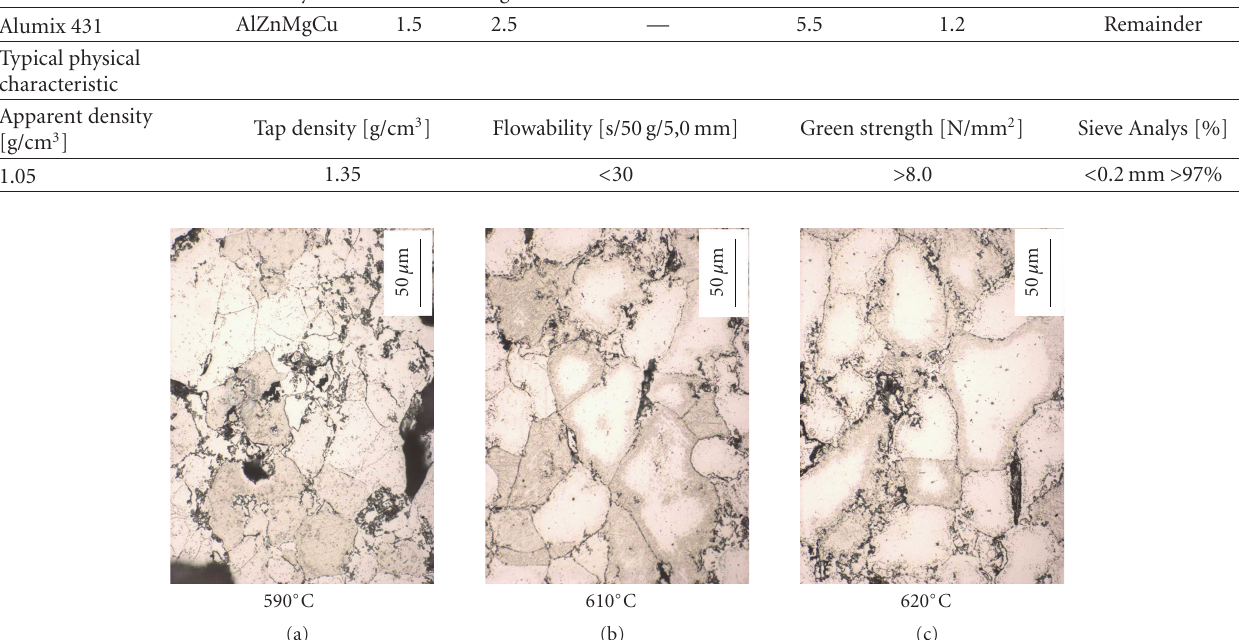
Figure 2: Microstructure of EA431, compacted at 400 MPa and sintered at indicated temperatures for 30 minutes in flowing N 2 .